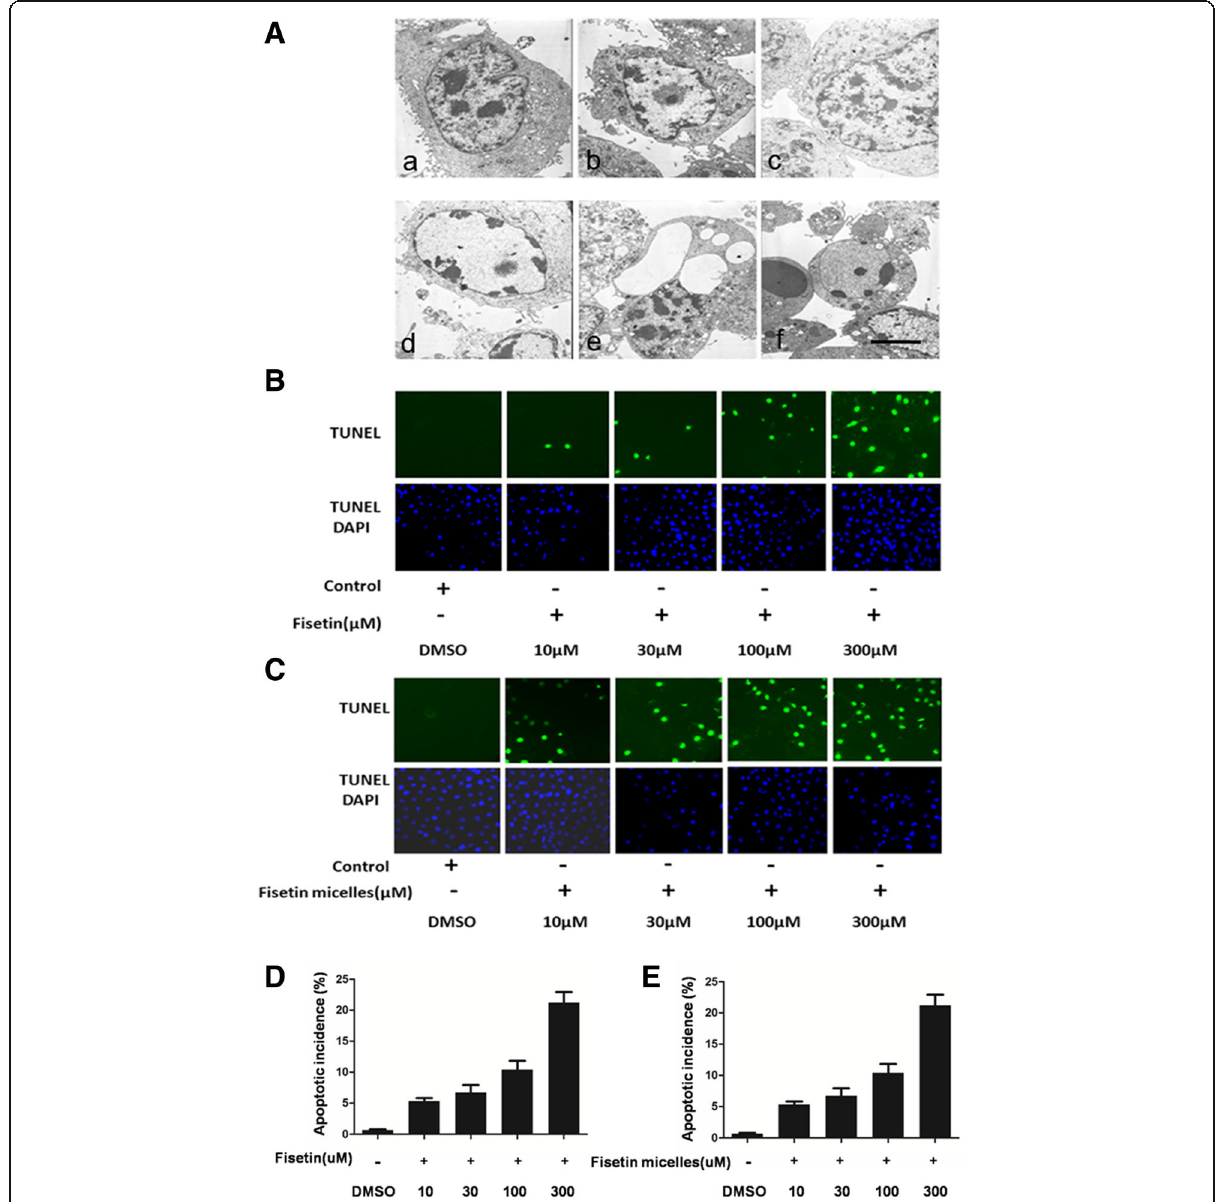
Fig. 2 Transmission electron microscopy of SKOV3 cells treated with fisetin (300 μ m) for 24 h. Images were recorded at 5000 × magnification using a transmission electron microscope. a (a) Normal structure of cancer cells. (b) Heterochromatin aggregation in the cell. (c) Structural changes before apoptosis. (d) Chromatin edge set and nuclear membrane thick dyeing. (e) Apoptosis cells. Membrane blebbing appeared inside the cells. (f) Apoptosis cells with apoptotic bodies, swelling of organelles. b - c SKOV3 cells were treated with different concentrations of fisetin/ fisetin micelles and labeled with TUNEL and DAPI after 24 h. Images of random fields ( n = 10) per slide ( n = 3) were collected at 400×. d - e Quantitative analysis of the apoptosis (TUNEL) he apoptotic cells were counted with at least 100 cells from four randomly selected fields in each group. Compared with control, fisetin/fisetin micelles treated SKOV3 cells showed obvious apoptosis in concentration-dependent manner. Representation figures of treated cells labeled for TUNEL and counterstained with DAPI are shown. Scale